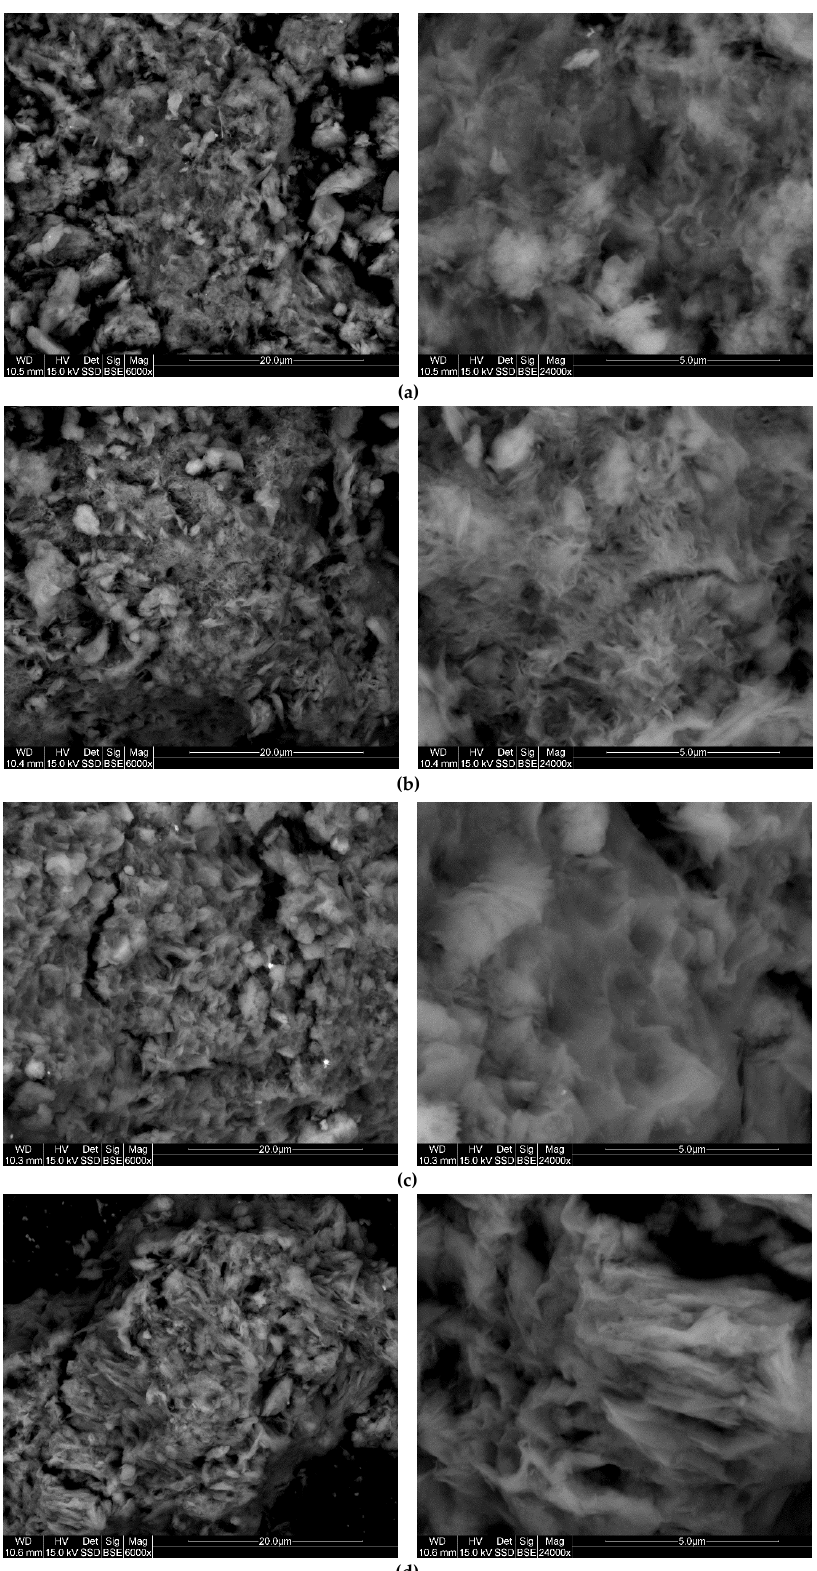
Figure 6. Scanning electron microscopy (SEM) images of samples: ( a ) BENT, ( b ) HD-B, ( c ) HD-TX- Figure6. Scanningelectronmicroscopy(SEM)imagesofsamples: ( a )BENT,( b )HD-B,( c )HD-TX-48, and 48, and ( d ) TX-48 (WD – working distance, HV – high voltage, Det – detector, Sig – signal, Mag – ( d ) TX-48 (WD—working distance, HV—high voltage, Det—detector, Sig—signal, Mag—magnification, magnification, SSD – Single Shot Detector, BSE – Backscattered Electrons). SSD—Single Shot Detector, BSE—Backscattered